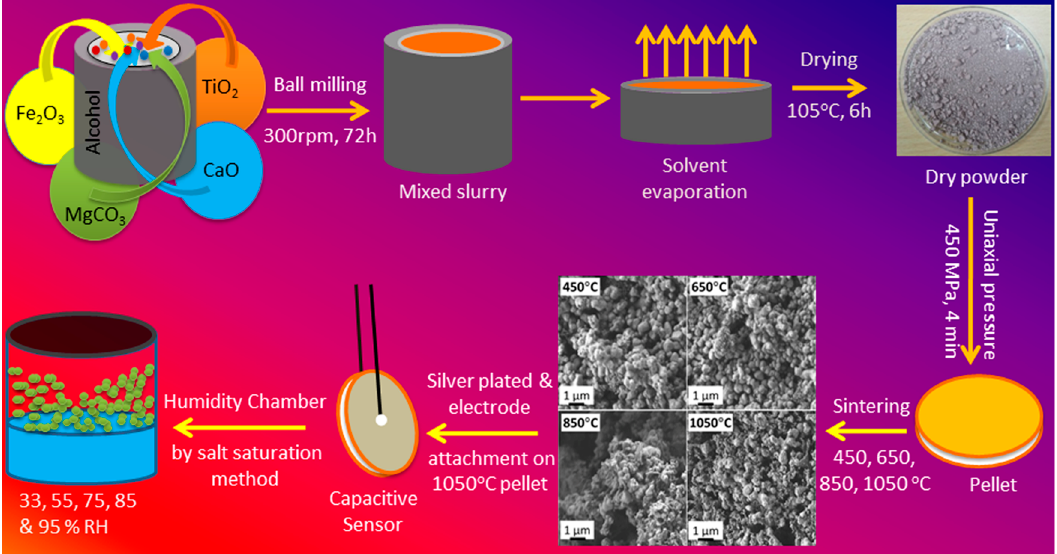
Figure 1. Flow chart for sensor fabrication with the morphology at different sintering temperature.